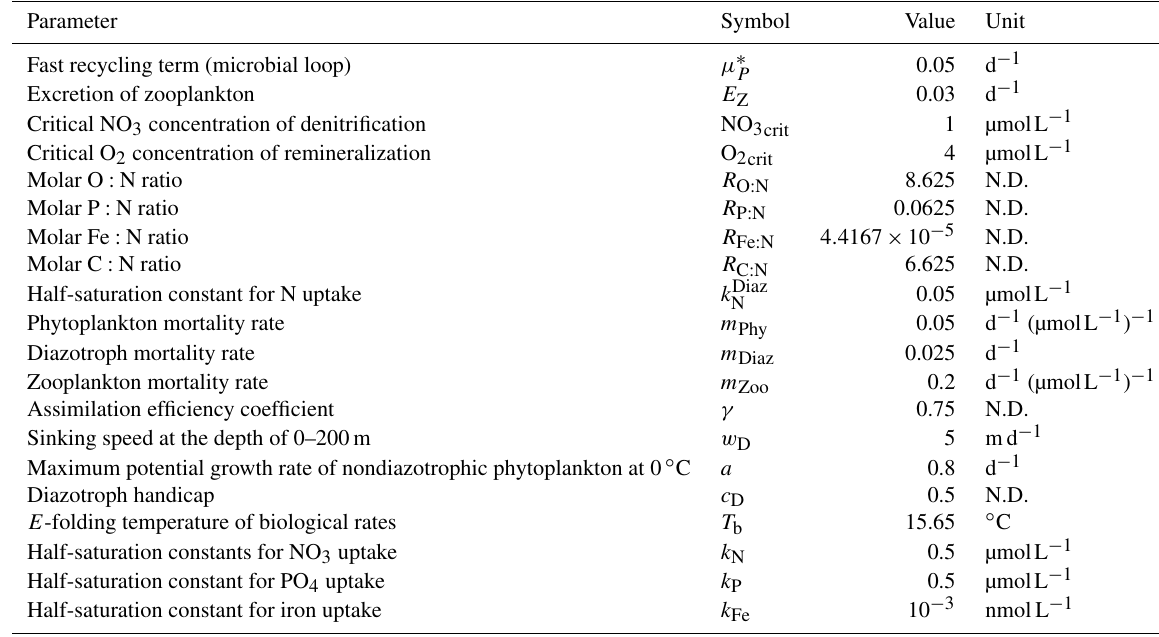
Table B1. Model parameters. Parameter